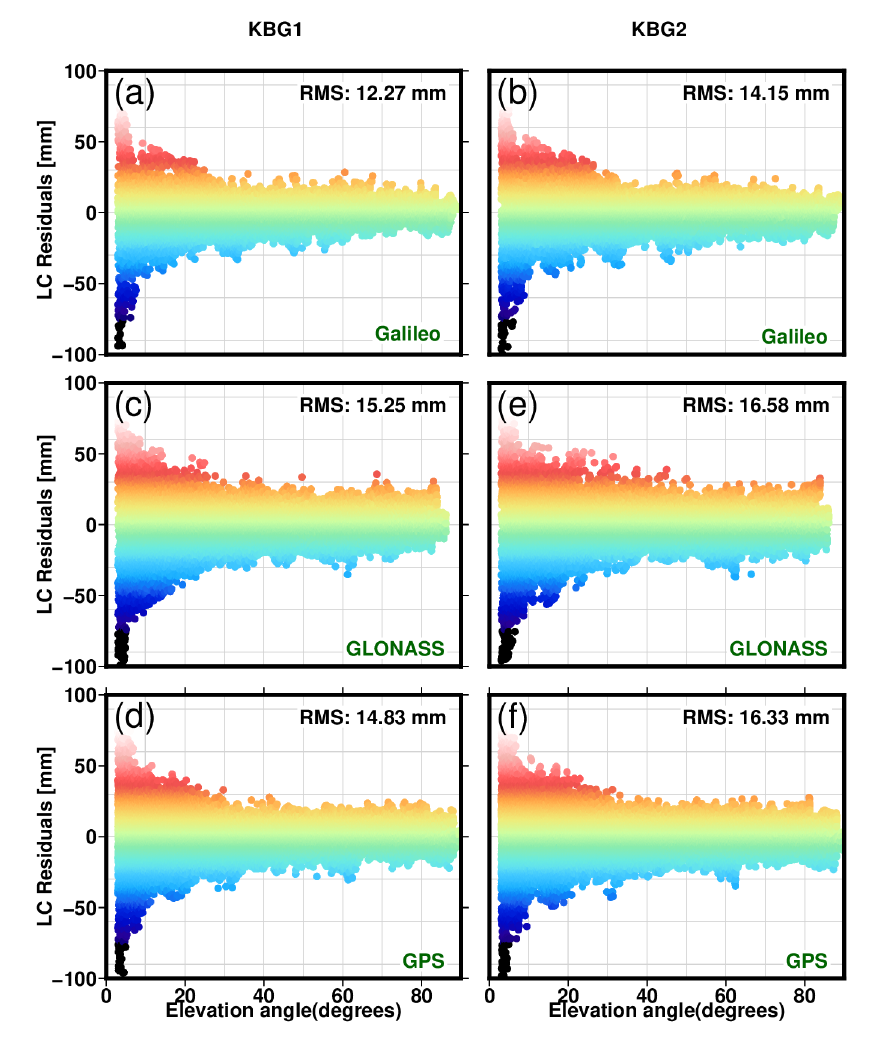
Figure 9. Post-fit LC carrier-phase residuals for individual GNSS constellations, i.e., Galileo ( a ), GLONASS ( c ) and GPS ( d ) for station KBG1 with Eccosorb and Galileo ( b ), GLONASS ( e ) and GPS ( f ) for station KBG2 without Eccosorb. The dataset was acquired on 1 March 2021. Furthermore, we computed the RMS of the post-fit carrier phase residuals for a 1 ◦ bin width for an elevation angle between 3 ◦ and 90 ◦ for the KBG1 and KNG2 stations, as depicted in Figure 10. The RMS value decreases by approximately about 1 mm for elevation angles between 3 ◦ and 35 ◦ ; after that, the effect of the Eccosorb material becomes insignificant, and the two stations show similar RMS